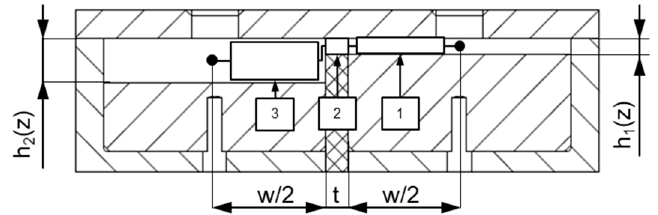
Figure 10. Initialization of the cross-channel connections over the barrier flight.